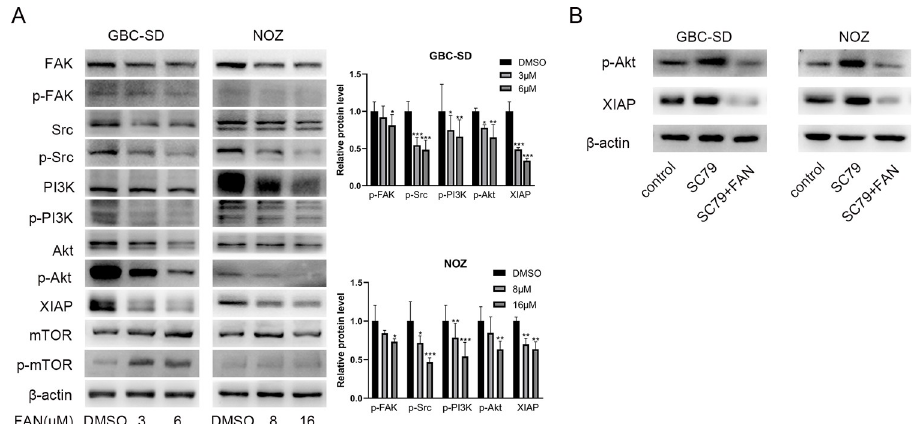
Fig 3. Fangchinoline inhibits the PI3K/Akt/XIAP signaling axis. (A) Results of FAK, p-FAK (Tyr576/577), Src, p- Src (Tyr527), PI3K, p-PI3K (Tyr458/Tyr199), AKT, p-AKT (Ser473), mTOR, p-mTOR (Ser2448), and XIAP relative protein expression using Western blot. (B) GBC cells were incubated with p-Akt activator SC-79 alone or combined with fangchinoline before lysis for Western blot. Data are presented as mean ± SD. � P < 0.05. �� P < 0.01 and ��� P < 0.001, compared with the DMSO group.